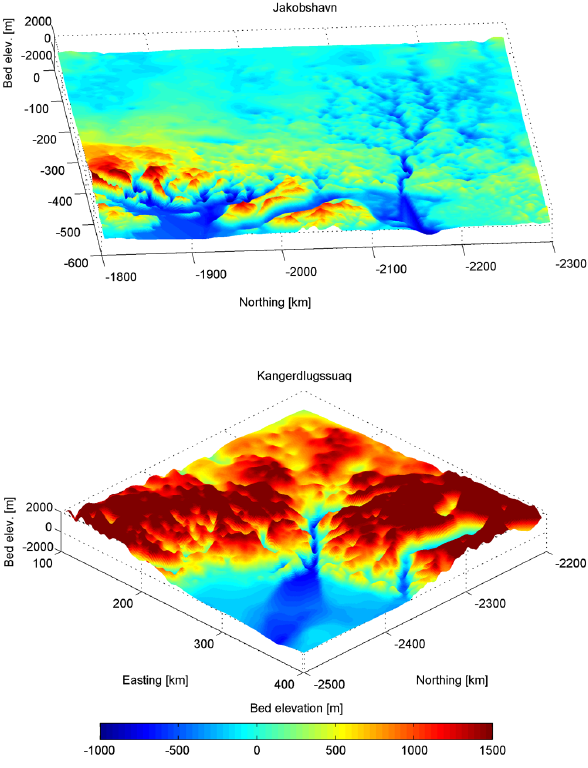
Fig. 5. (a) Shaded relief plot looking inland from the coast with the mouth of Jakobshavn Isbrae at about − 2150km Northing. (b) as for (a) but for the Kangerdlugssuaq glacier